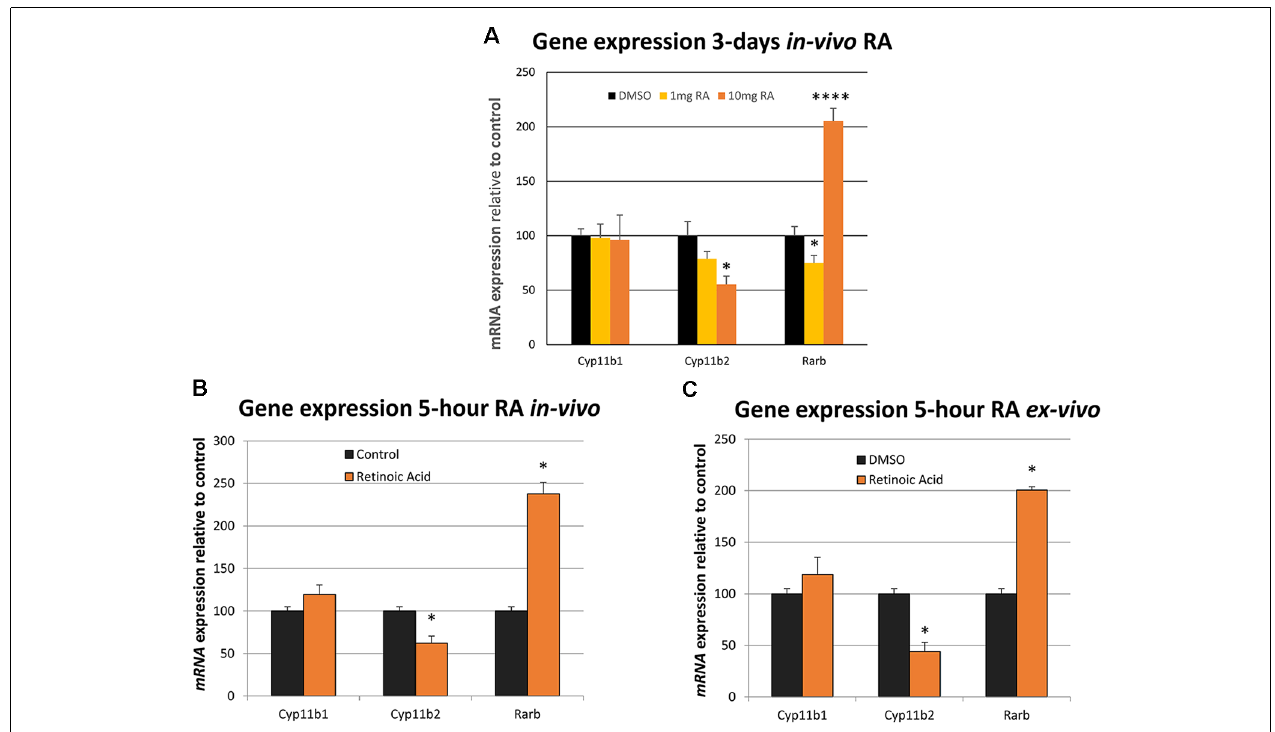
FIGURE 2 | The influence of in vivo and ex vivo RA treatment on adrenal gland Cyp11b1, Cyp11b2 and Rarb expression. (A) The relative effects of 1 mg/kg vs. 10 mg/kg dose of RA in the rat was compared on gene expression and there was no influence on Cyp11b1 at either dose (1 mg/kg RA, p = 0.882, 10 mg/kg RA, p = 0.874) while Cyp11b2 was repressed at the higher dose (1 mg/kg RA, p = 0.188, 10 mg/kg RA, p = 0.018). Rarb was strongly induced by the 10 mg/kg RA dose ( p = 0.00009) but surprisingly repressed at 1 mg/kg RA ( p = 0.048). (B) Five-hour treatment of the rat with RA resulted in significant induction of the Rarb positive control in the adrenal gland and Cy11b2 fell in expression ( p < 0.001 and p = 0.018, respectively). (C) Five-hour treatment with RA of an ex vivo adrenal glands culture resulted in Rarb again increasing and Cyp11b2 falling in expression ( p = 0.0188 and p = 0.0184, respectively). ∗ = p < 0.05 , ∗∗∗∗ = p <